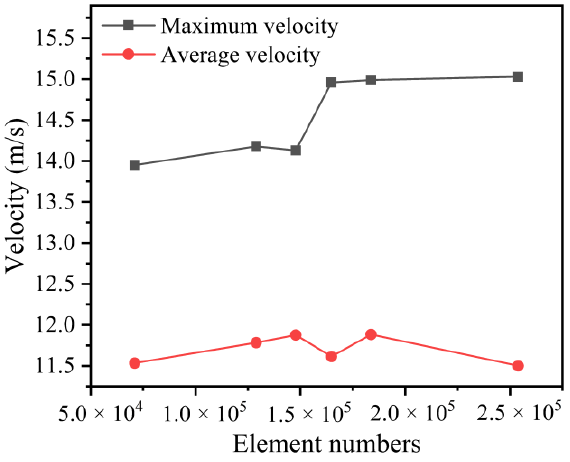
Figure 2. Effect of the number of grids on the simulation results.